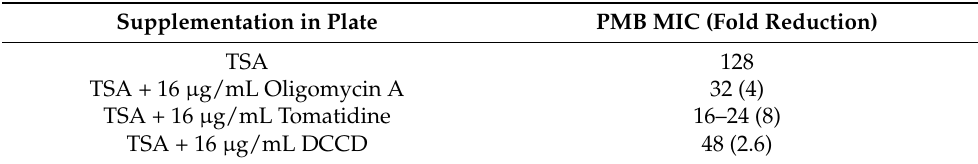
Table 2. ATP synthase inhibitors sensitizes S. aureus JE2 to polymyxin B (PMB). Minimum inhibitory concentration (MIC) in µ g/mL. TSA: tryptic soy